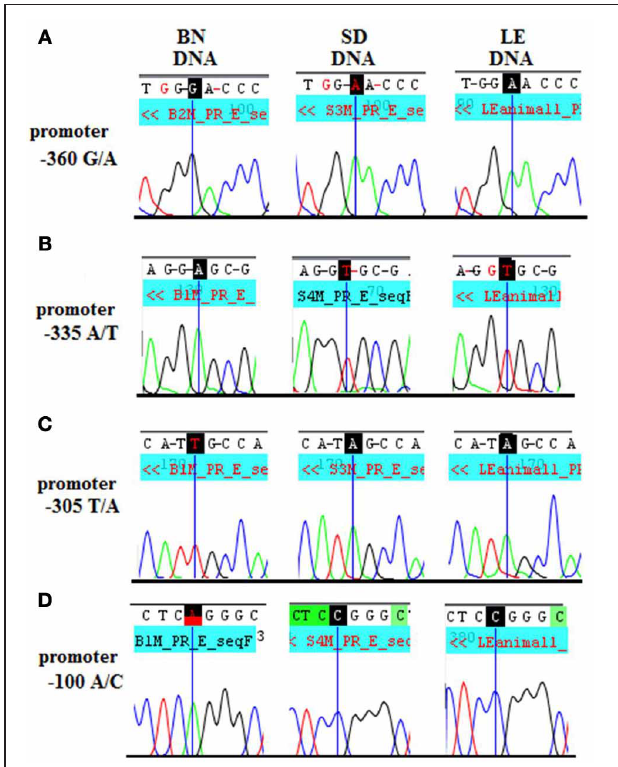
FIGURE 3 | Standard sequencing traces of four novel polymorphisms within the Dio3 promoter region and their location relative to the Dio3 start site. (A) G/A at − 360 bp upstream of Dio3 ; (B) A/T at − 335 bp; (C) T/A at − 305 bp; and A/C at − 100 bp. BN genotype is given first, followed by SD and LE. BN genotype differs from the matching SD and LE genotype at each polymorphic site and (D) A/C at − 100bp.